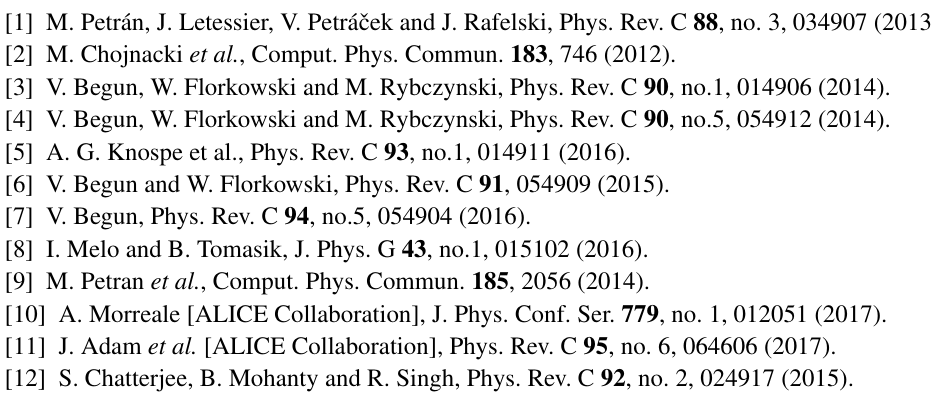
Ξ (1530) than BEC. There is a significant dependence of the spectra on the freeze-out hypersurface for heavy strange baryons in BEC, while in EQ only Σ (1385) is sensitive to the hypersurface, see Figs. 5,